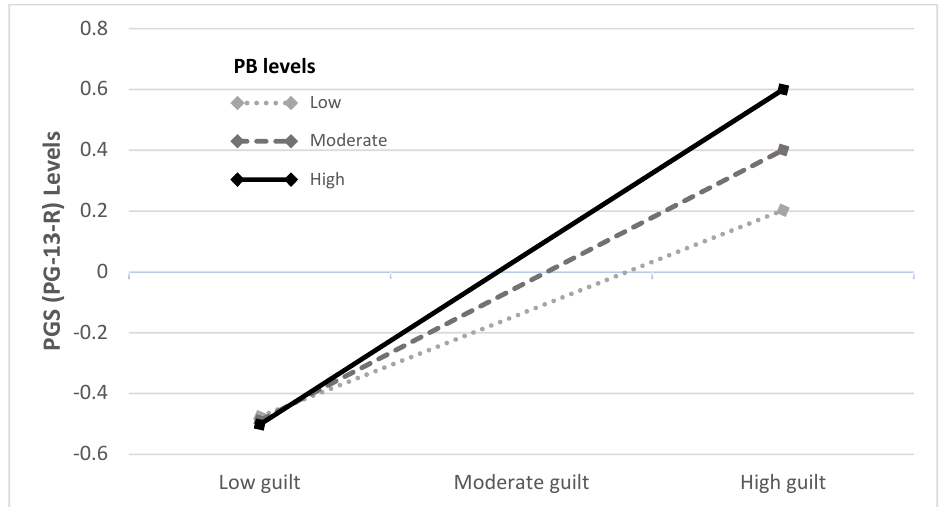
Figure 1. The association between guilt and PGS as moderated by PB levels ( n = 152). PB = perceived burdensomeness. PGS = prolonged grief symptoms.